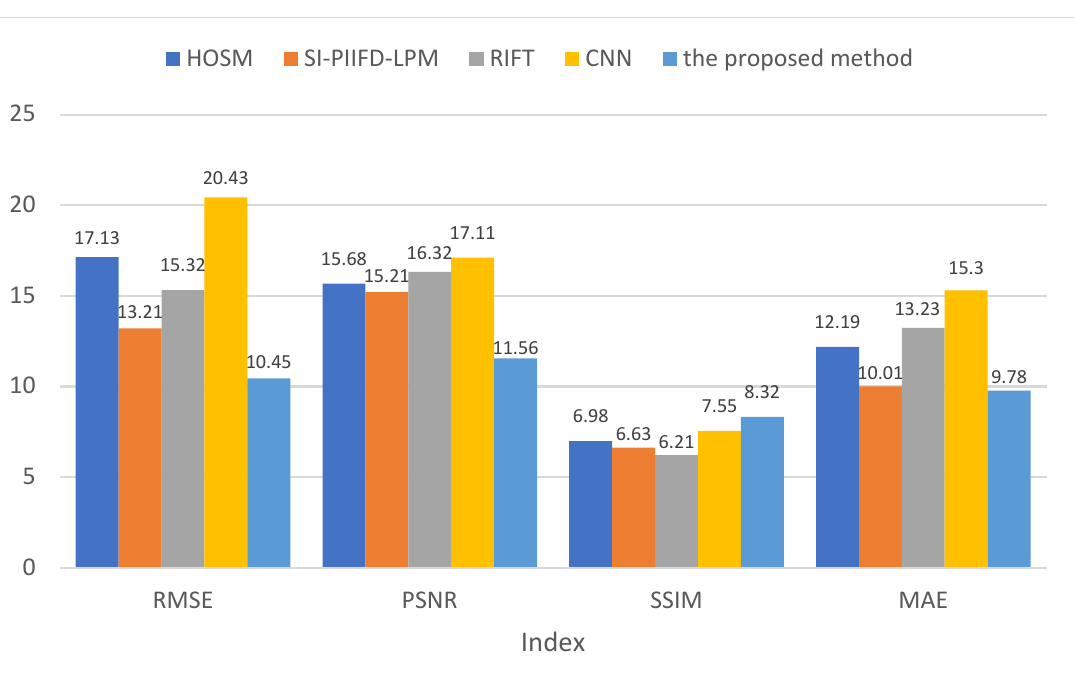
Figure 12. Registration results on the dataset of Ma et al..